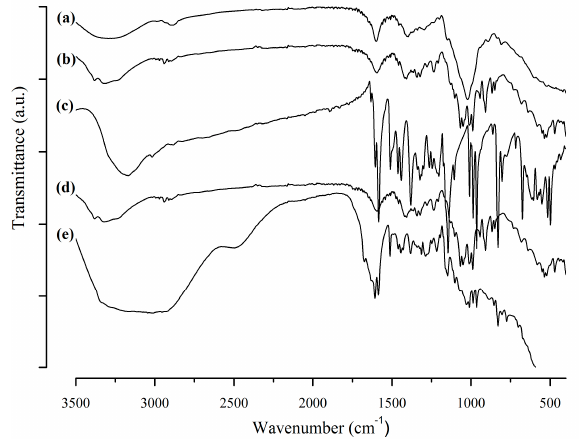
Figure 1. ATR-FTIR spectra of (a) gellan gum, (b) pectin, (c) resveratrol, (d) empty beads, and (e) RES-loaded beads.